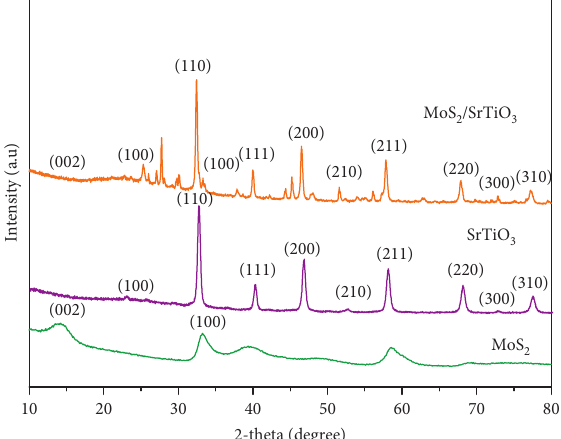
Figure 3: XRD patterns of pure MoS 2 nanosheets, porous SrTiO 3 nanofibers, and SrTiO 3 @MoS 2 composite